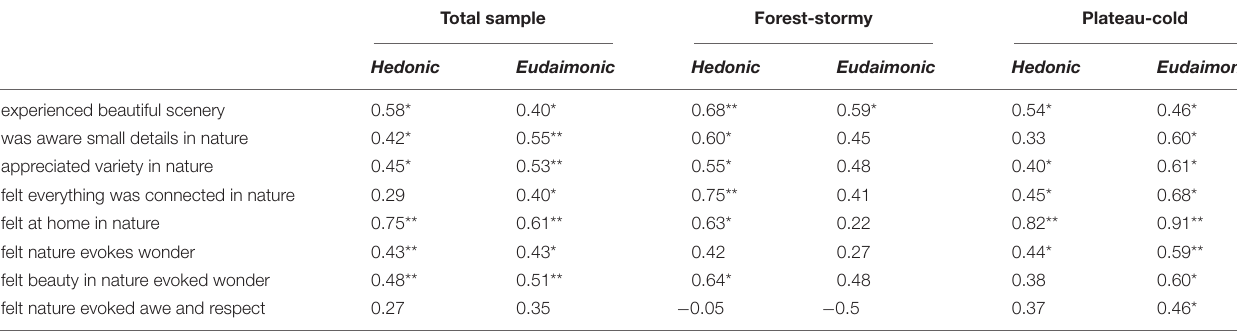
TABLE 2 | Correlations between aesthetic nature experiences and feeling states.